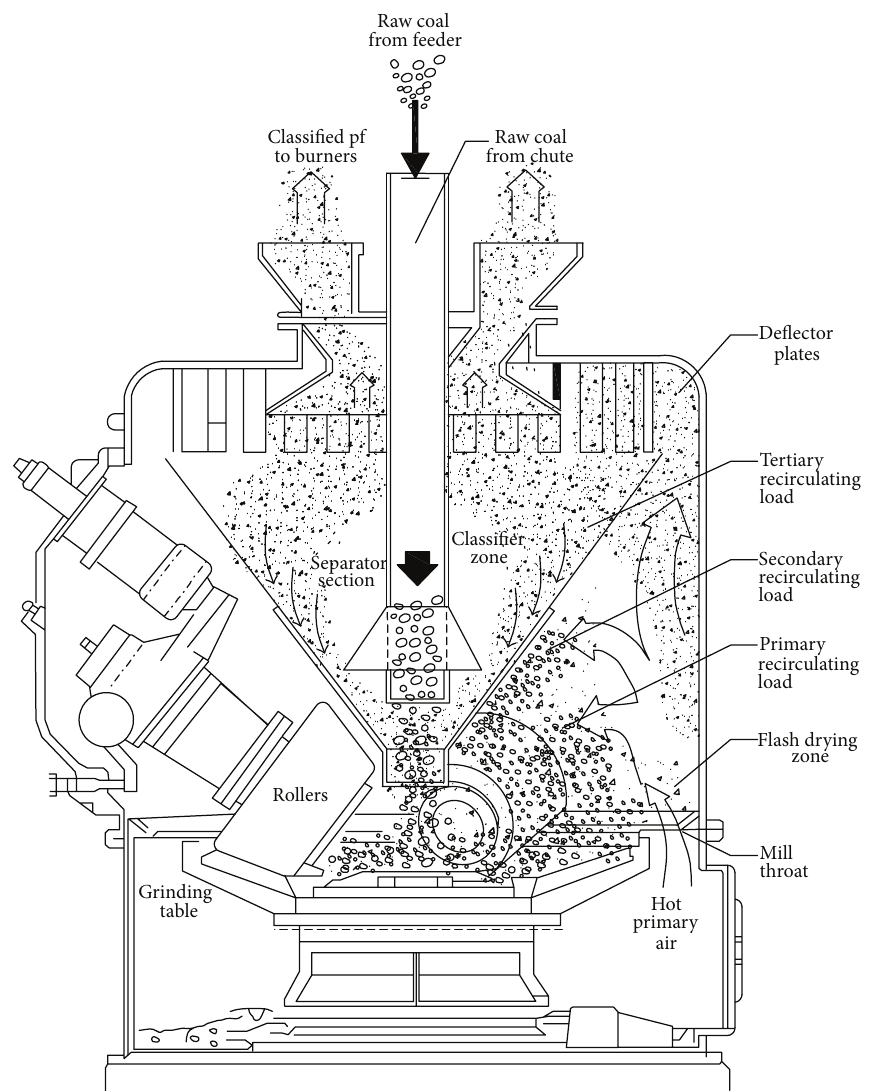
Figure 1: Configuration of the coal grinding subsystem.